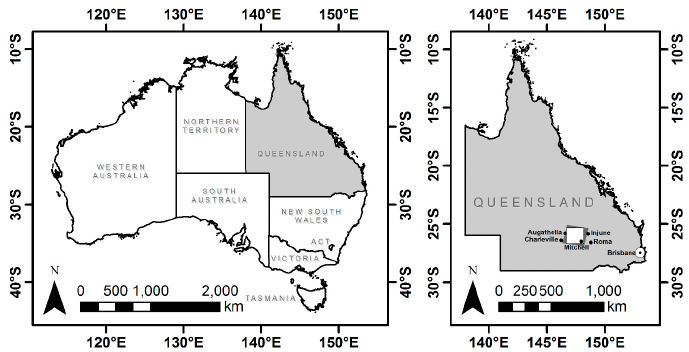
Figure 1. Study area: The Queensland study area is displayed as the white rectangle. The corresponding full Landsat frame (WRS-2 path/row 093/078) is indicated by the dark grey box. The largest settlements in and near to the study area are displayed.